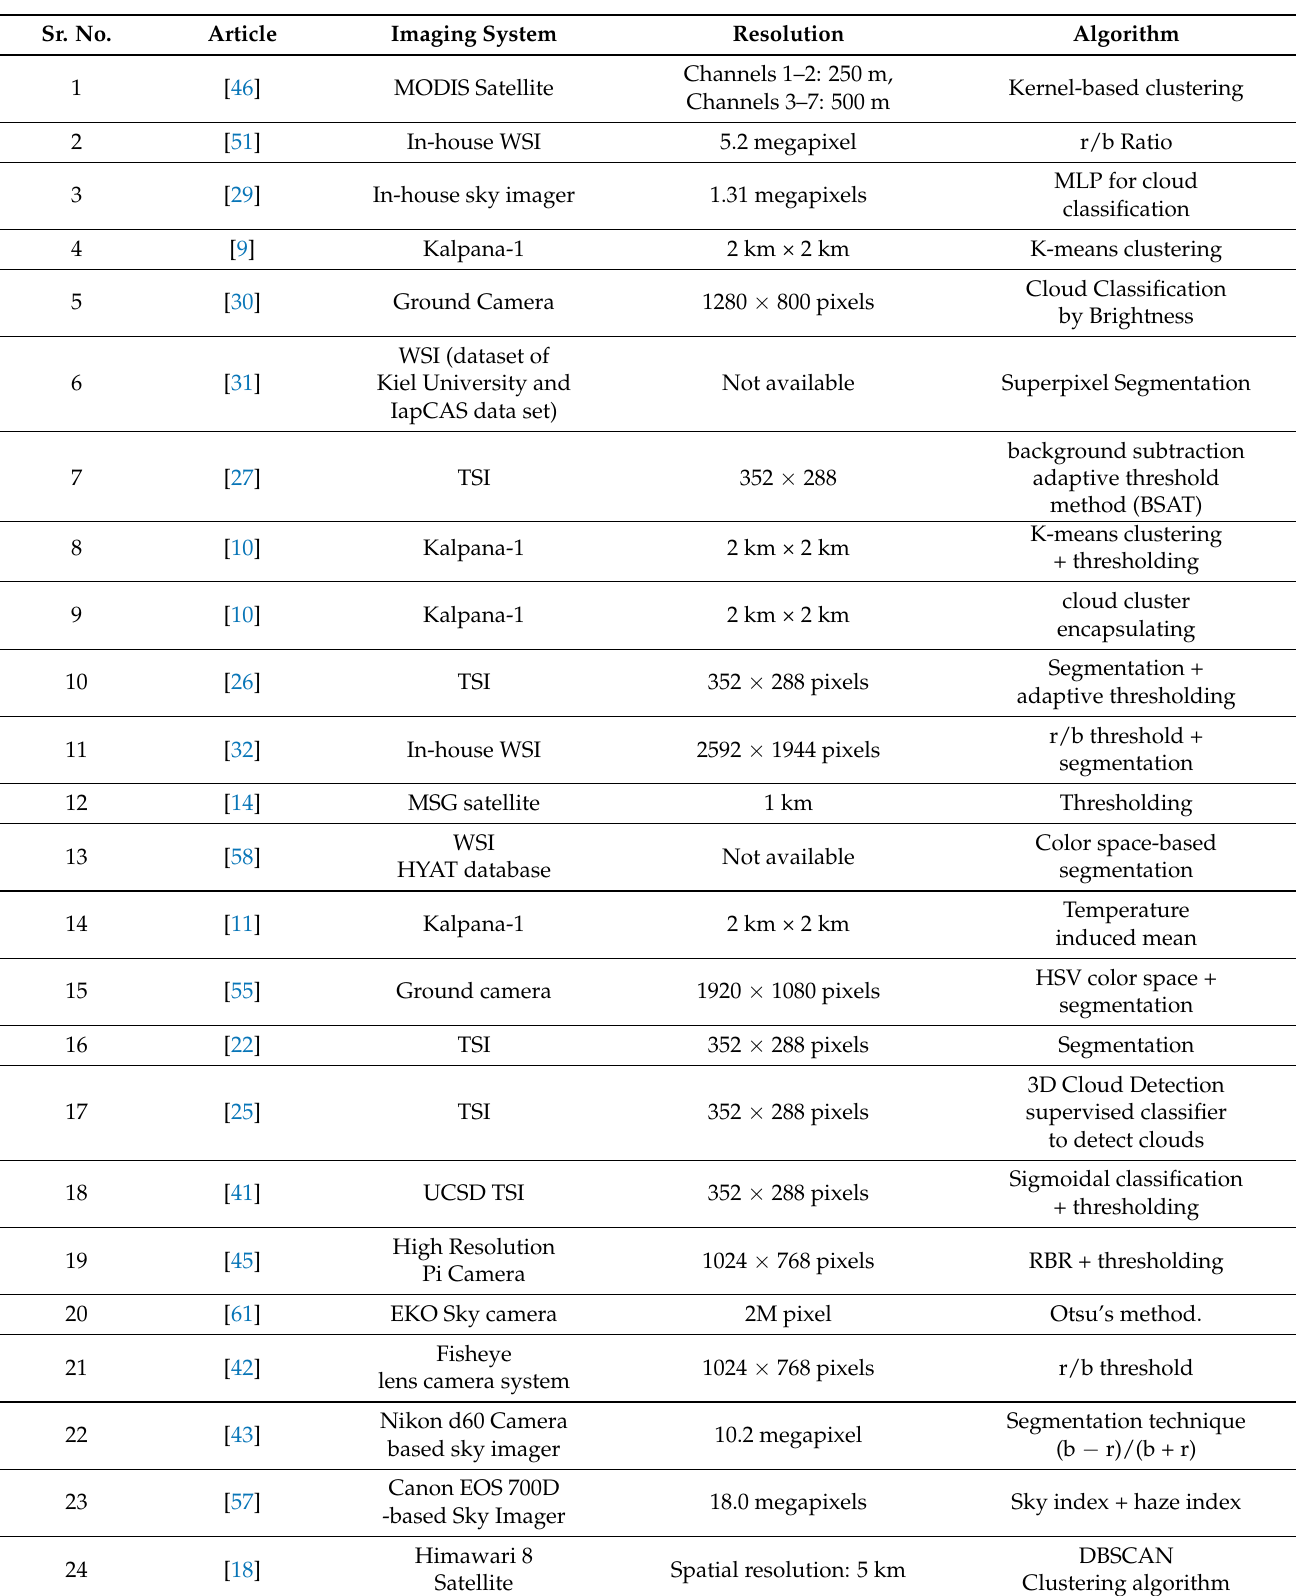
Table 1. State-of-the-art methods in cloud